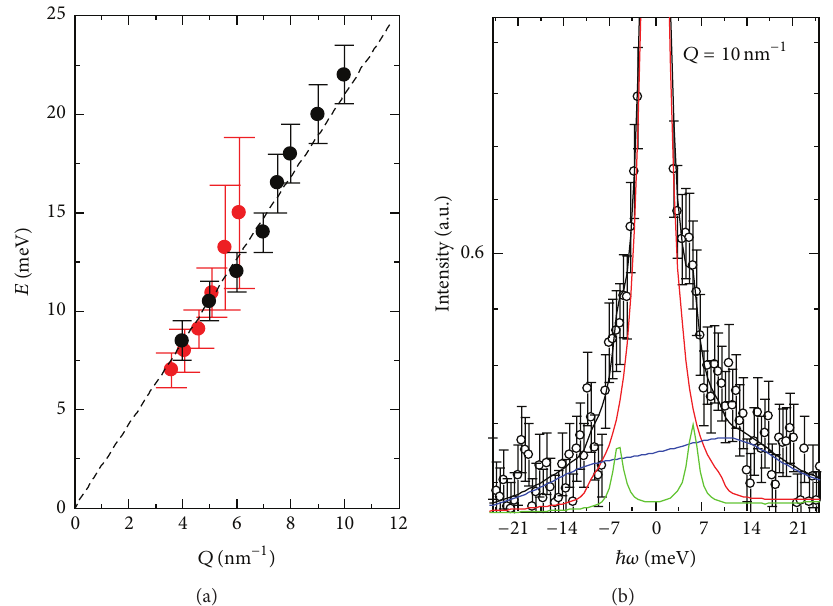
Figure 6: (a) Comparison between the dispersion curves of the “fast sound” mode as determined by INS [27] (red dots) and IXS [9] (black dots). The linear best fit of IXS data is also reported for reference as a dashed straight line. (b) A typical raw spectrum (open circles) measured by IXS [12] at 𝑄 = 10 nm −1 (open circles) along with its best fitting of (1) the total line-shape (black line), (2) the quasielastic contribution (red line), and (3) the low (green line) and (4) the high (blue line) frequency inelastic